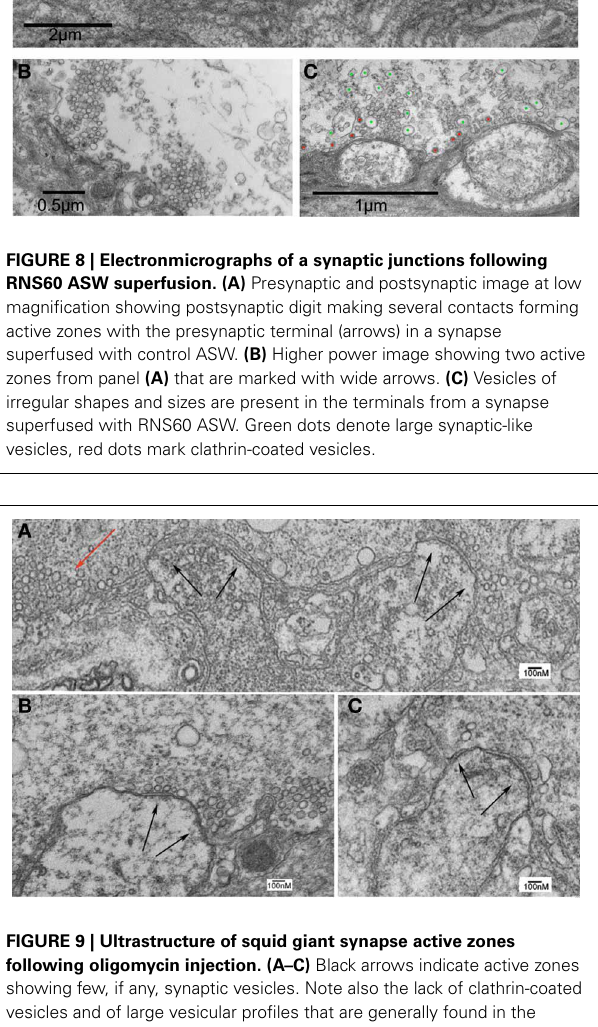
synapses ( Figure 9 ) indicate that while the ultrastructure is not grossly altered, the numbers of vesicles of all types in the vicinity of the active zones are very much